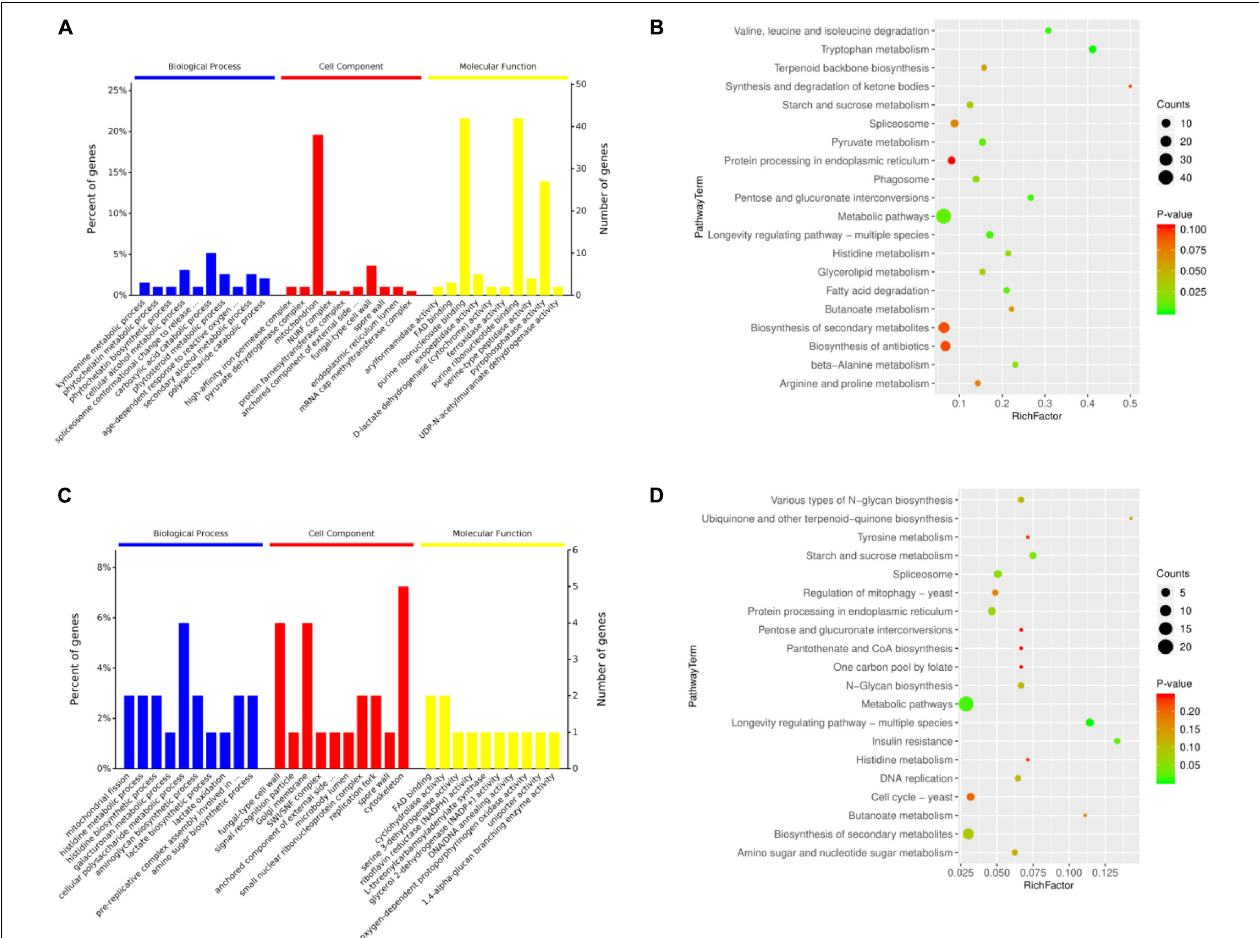
FIGURE 3 | Bioinformatics analysis of (A,B) the total 239 and (C,D) a subset of 75 differentially expressed proteins (DEPs) in brown film formation in Lentinula edodes . (A,C) Ten most significantly enriched terms in each category (biological process, cell component, molecular function) in the level 6 gene ontology hierarchy, with the percentage (left) and number (right) of genes involved with a term. (B,D) Enriched KEGG pathways clustered into metabolism subcategories, with number of proteins involved in a specific pathway and value of Rich Factor